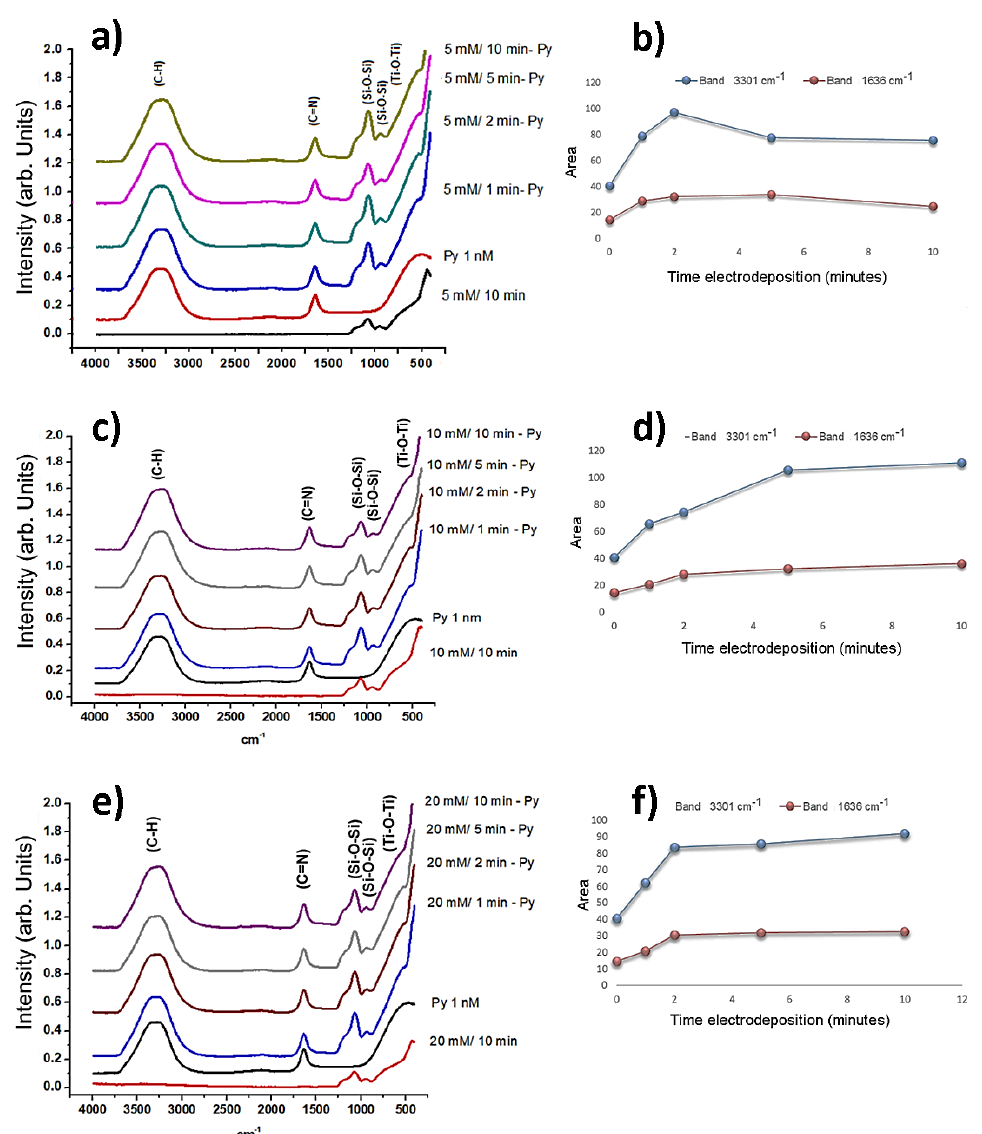
Figure 7. Infrared spectra of 1 nM pyridine on the supports doped at different times and concentration: ( a , b ) AgNO 3 at concentration of 5 mM (at 1, 2, 5 and 10 min); ( c , d ) AgNO 3 at concentration of 10 mM (at 1, 2, 5 and 10 min); ( e , f ) AgNO 3 at concentration of 20 mM (at 1, 2, 5 and 10 min). Note: pyridine solution and the supports alone are annexed.